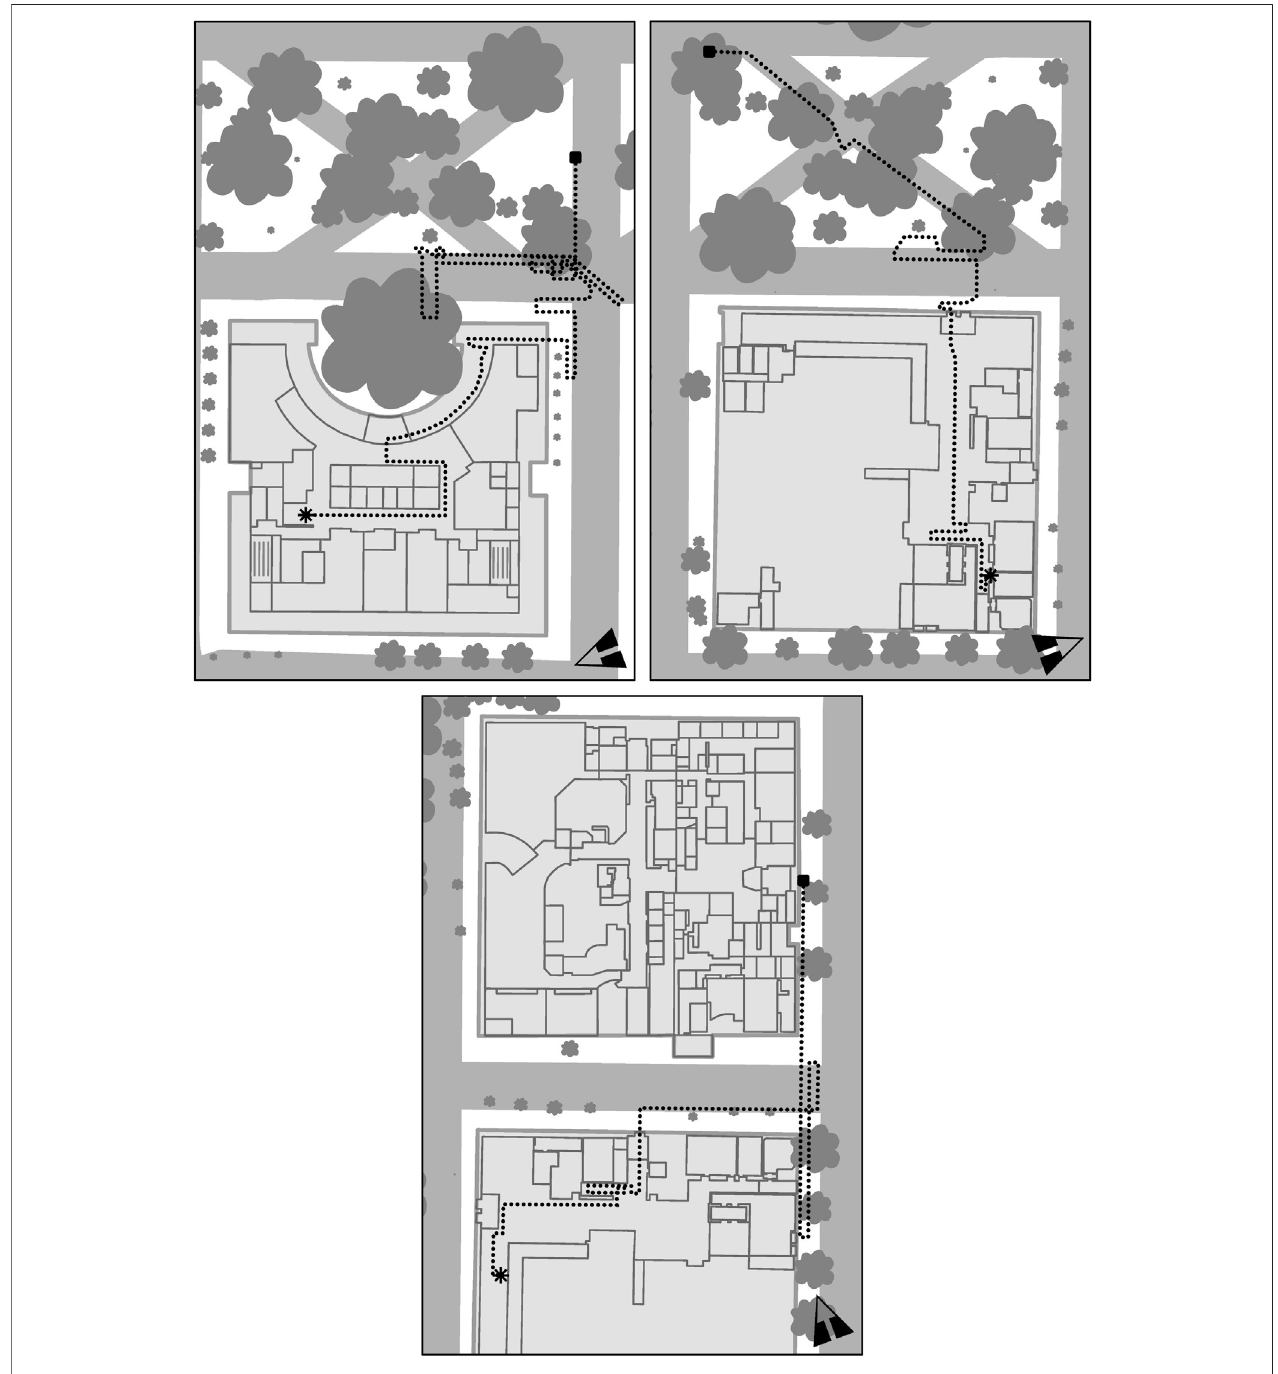
FIGURE8| Maps oftheobservedroutes thatweretakenbytheparticipantduring theway fi ndingexperiment. Theroutesarepresented intheorderofcompletion, with Route B (modality: written directions) shown at the top left, Route C (modality: tactile map) at the top right, and Route A (modality: mobile app) at the bottom.